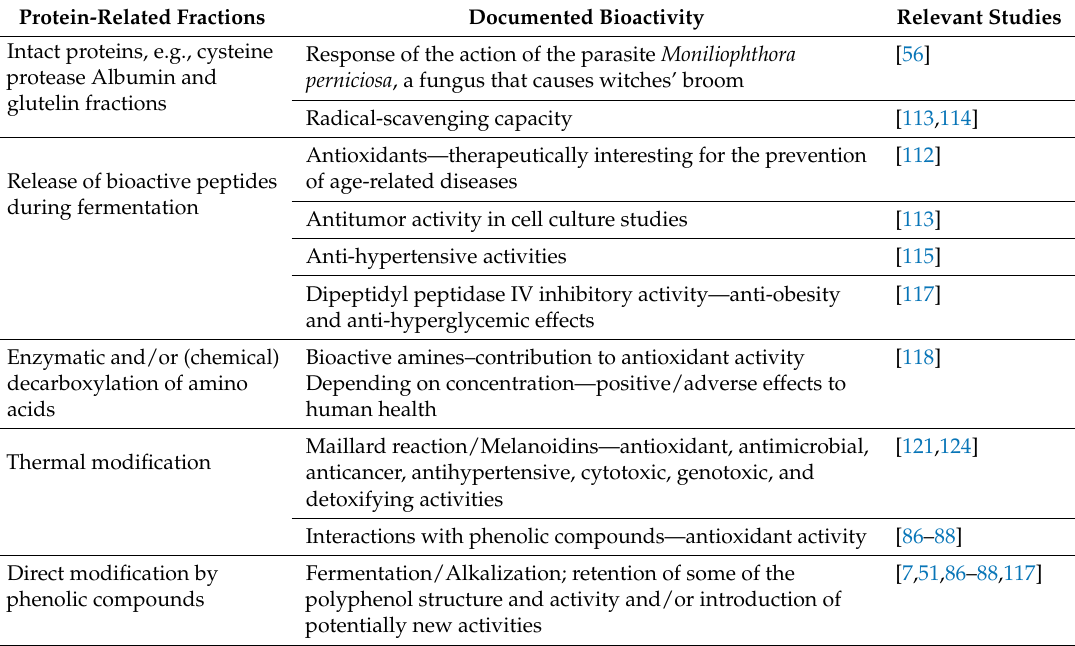
Table 2. Selected examples for bioactivity potentials connected with cocoa protein